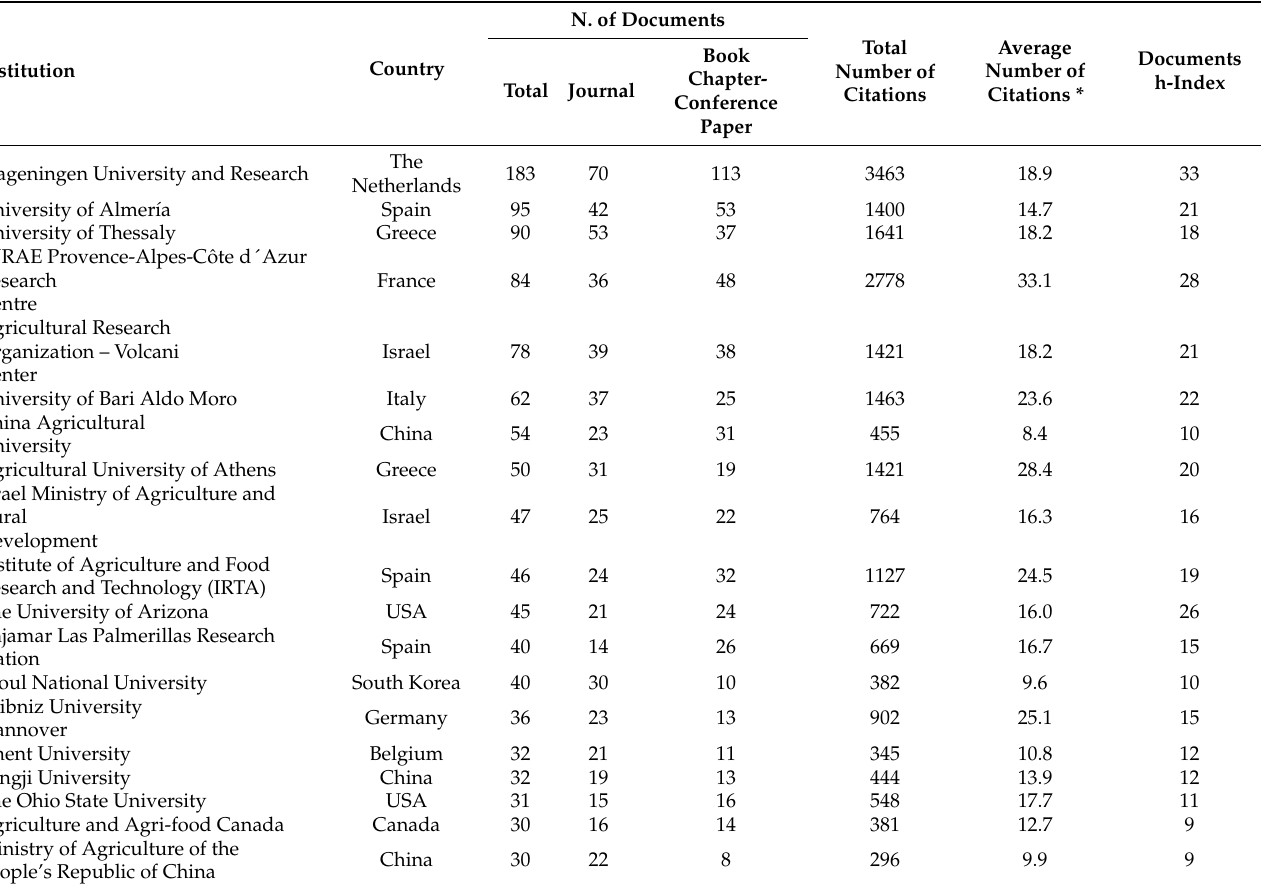
Table 2. The most productive institutions publishing at least 30 articles on greenhouse engineering from 1981 to